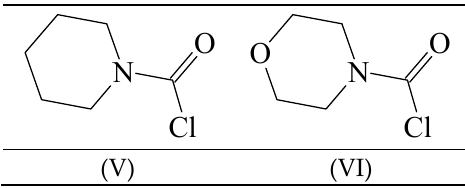
Figure 2. Structures of 1-piperidinecarbonyl chloride (V) and 4-morpholinecarbonyl chloride (VI).